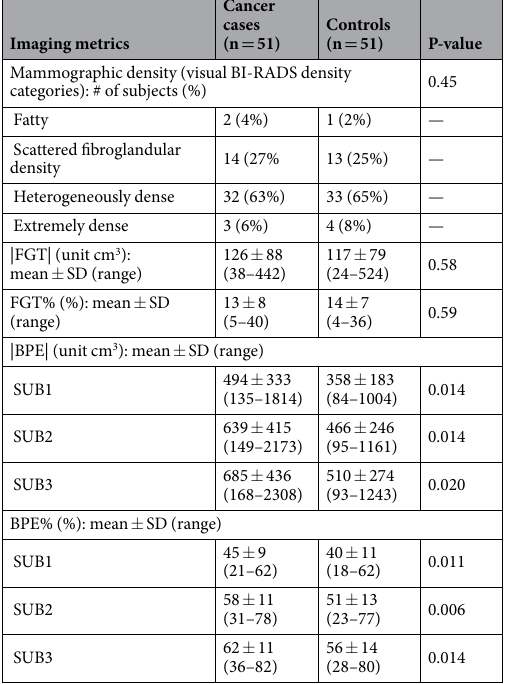
Table 2. Imaging measure characteristics in the contralateral breast for 51 breast cancer cases and 51 controls matched by age and year-of-MRI scan. FGT = Fibroglandular tissue. BPE = Background parenchymal enhancement. SUB1, SUB2, SUB3 = Subtraction sequence (i.e., post-contrast – pre-contrast) for each of first, second, and third post-contrast sequences, respectively. * Shown BPE and FGT measure summaries are from the contralateral negative breast of both cancer cases and controls. The p-values are for comparison of controls to cancer cases using paired